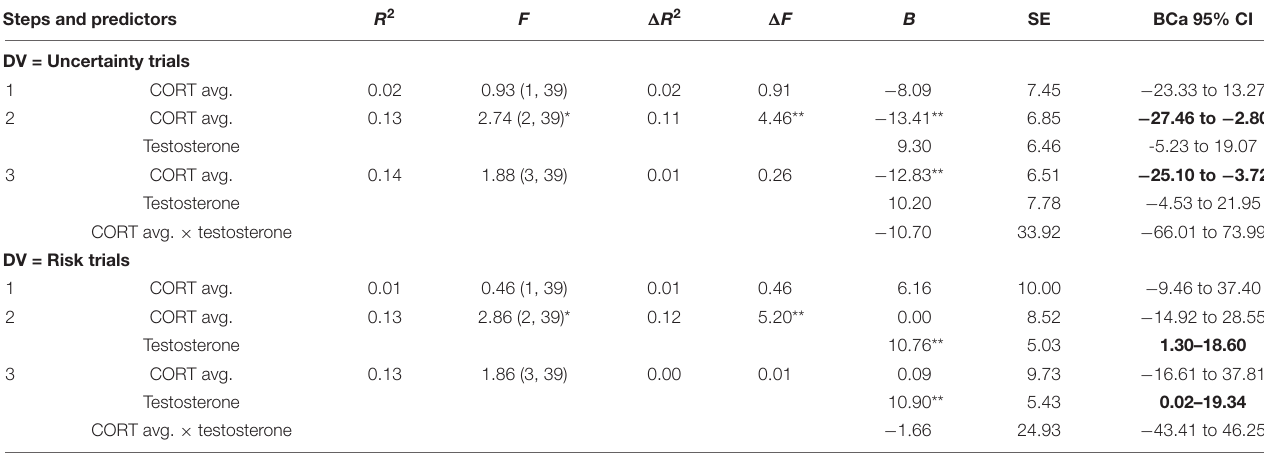
TABLE 1 | Results of hierarchical regression using average cortisol (step 1), testosterone (step 2), and average cortisol × testosterone (step 3) to explain Iowa gambling task (IGT) decision-making in the uncertainty and risk phases. Steps and predictors